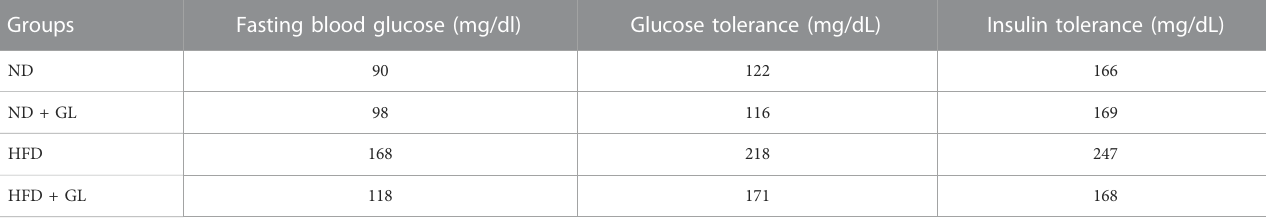
TABLE 7 G. lucidum (GL) reduces fasting glucose levels, glucose tolerance, and insulin tolerance in HFD-fed mice.